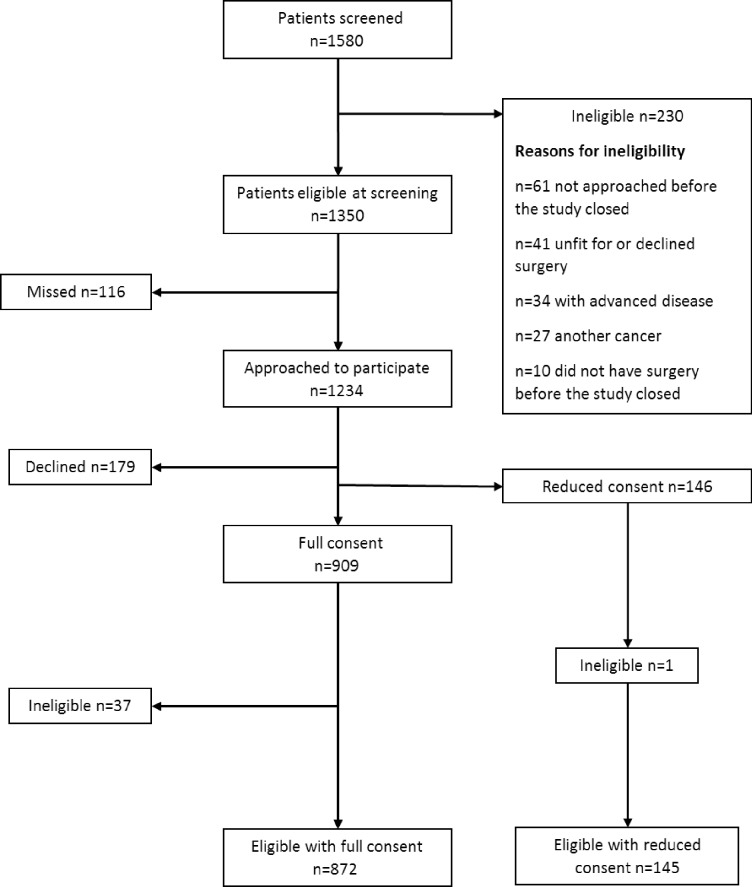
CREW recruitment flowchart.